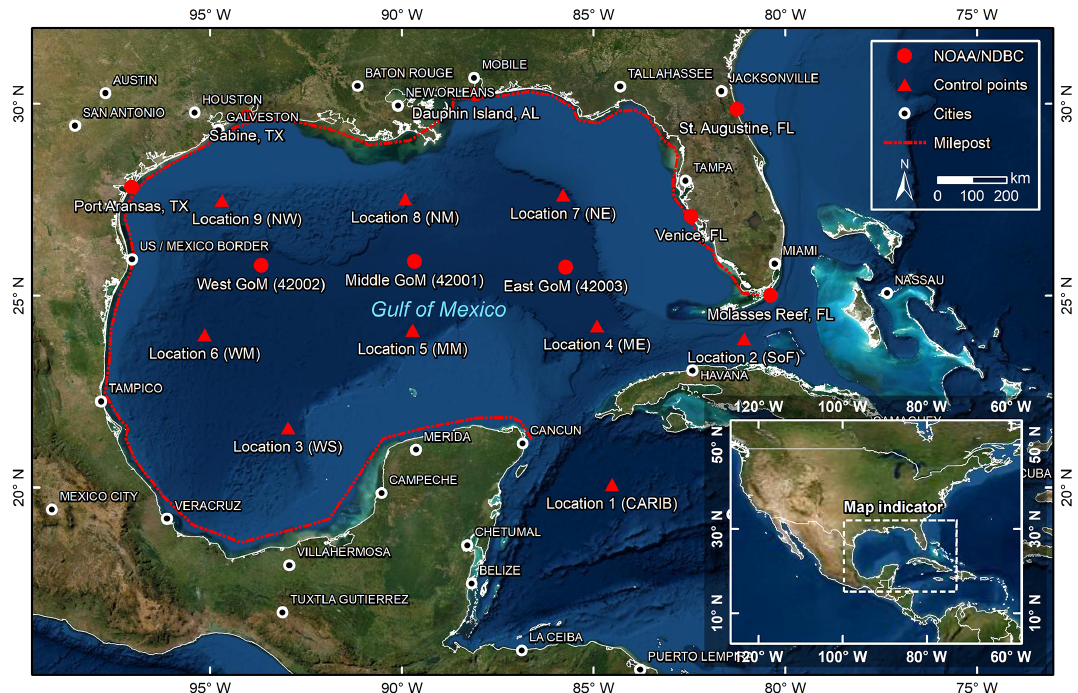
Figure 2. Area of interest of the Gulf of Mexico, including the locations of the nine control points in the GoM (red triangles), NOAA/NDBC measurement location (red dots), cities (white circles) and milepost (red dashed line). © Esri, DigitalGlobe, GeoEye, Earthstar Geographics, CNES/Airbus DS, USDA, USGS, AeroGRID, IGN and the GIS User Community. Sect.